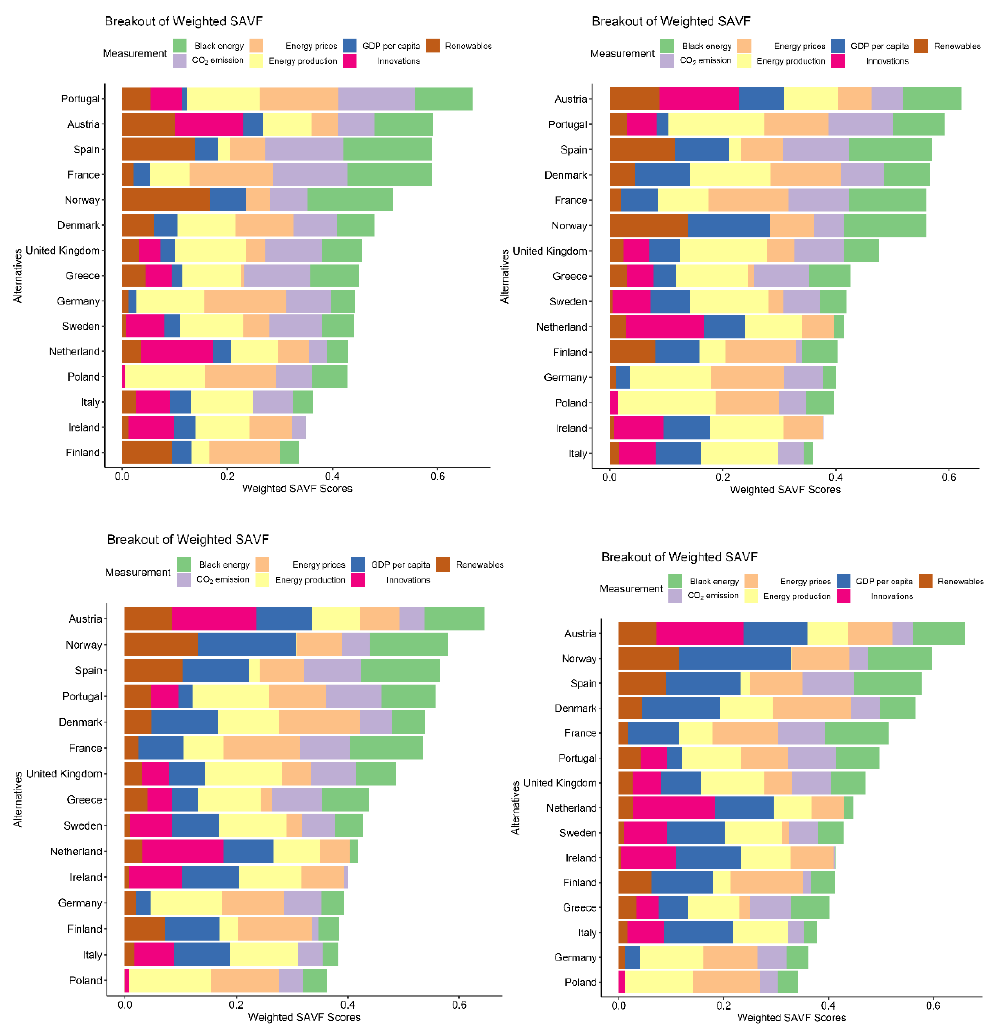
Figure 11. Influence of used variables on the overall SISED for all EU countries in 2011–2014.